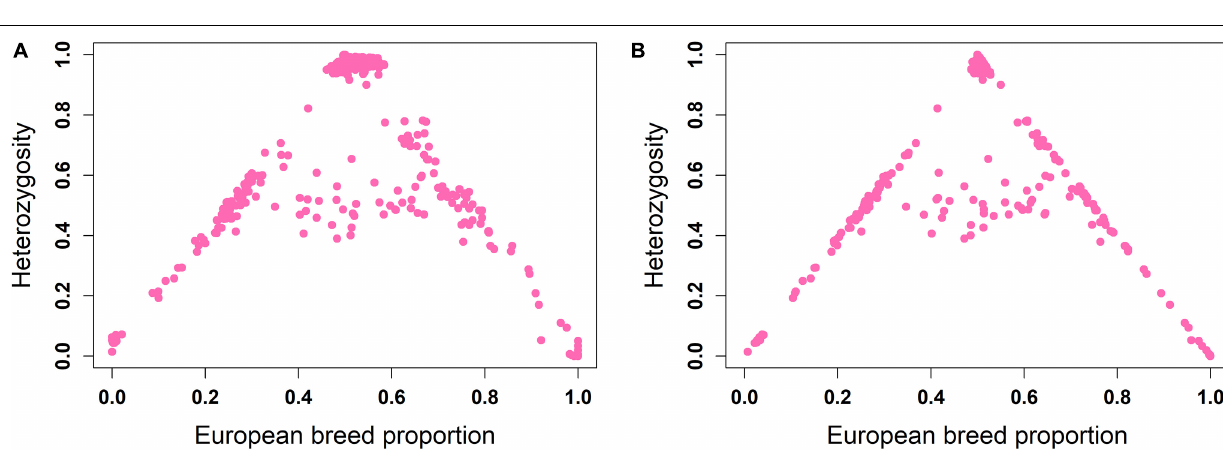
were clustered in the first band (between PC1 = − 0.025 to 0.000 and PC2 = − 0.02 to − 0.01), while the majority of Gobra × Montbéliarde and Gobra × Normande crosses were clustered in the other band. A substantial number of undefined crossbred animals were clustered in one or the other of the two bands with ancestral origin heterozygosities close to 1.0, showing that they are Gobra x Holstein-Friesian and Gobra x Montbéliarde F1